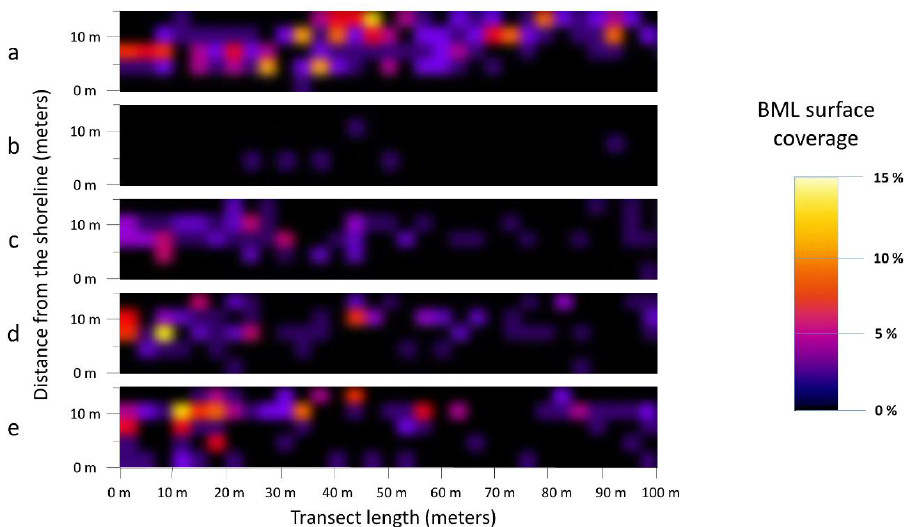
Figure 8. Variation in beached marine litter surface coverage of the monitored area, over time, for the first temporal period (from April 2019 to July 2019). The sequence of strips, from ( a ) to ( e ), shows the beach before the first total cleaning in ( a ), immediately after the first cleaning in ( b ), and at the following dates of our monitoring in ( c ), ( d ), and finally ( e ), after 90 days. The correspondent dates were: ( a ) 15 May 2019; ( b ) 24 May 2019; ( c) 04 June 2019; ( d ) 25 June 2019; and ( e ) 13 July 2019. The accumulation of waste is displayed both qualitatively and quantitatively using a color gradation, which corresponded to the percentage of the surface area covered by the objects in relation to the total area. The sequence shows the pattern of spatial and temporal distribution, with a clear increase in waste accumulation in the upper part of the strips (the dune zone).